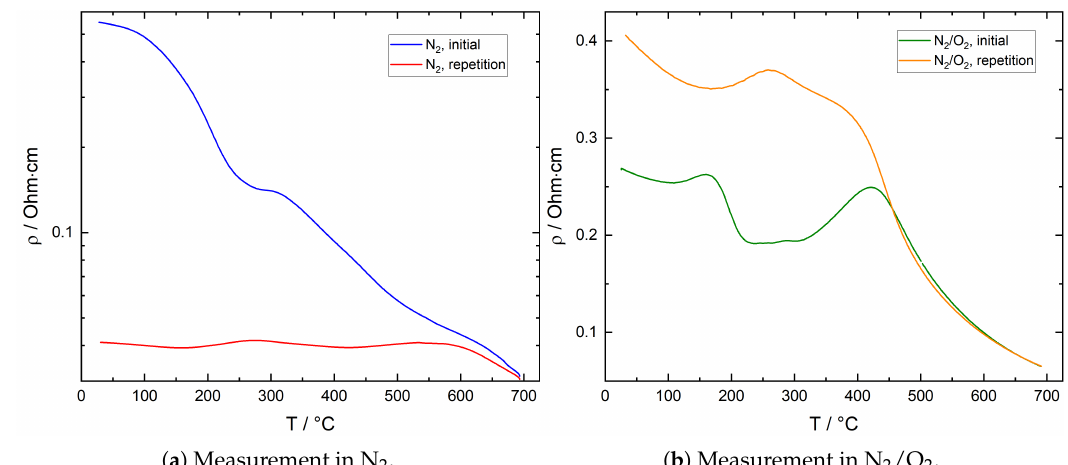
( a ) Measurement in N 2 . ( b ) Measurement in N 2 /O 2 . Figure 10. Electrical resistivity of ITO thick film as a function of temperature measured in ( a ) N 2 and ( b ) N 2 +12.5vol% O 2 (N 2 /O 2 ). Initial measurement after 1 h of film exposure to ambient air at room temperature, repetition measurement after cooling to room temperature following the initial measurement, without changing gas composition. In ( a ), a logarithmic resistivity axis scale was